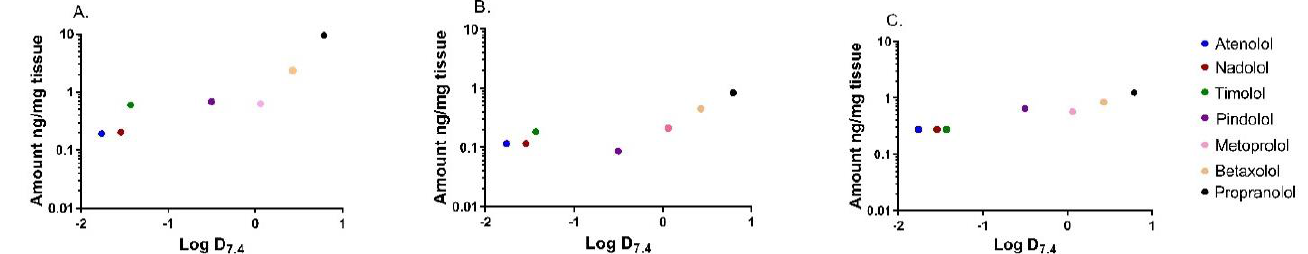
Figure 2. The concentrations of beta-blocking drugs after epithelial side drug exposure ex vivo at 180 min. The concentrations